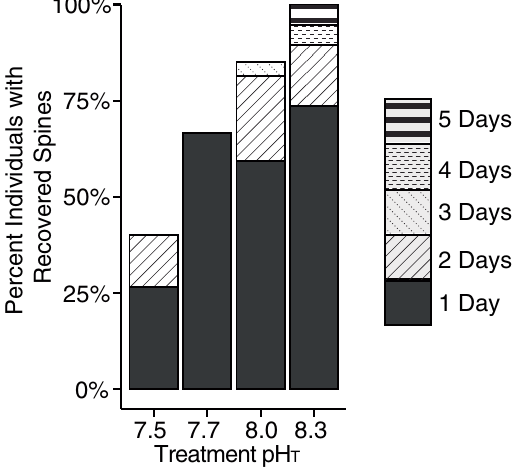
Figure 3. Percentage of individual foraminifera that regrew spines at each of four pH conditions. The number of days between experiment start and regrowth are shown in patterned bars. After 5 days, significant differences were found between foraminifera exposed to pH 7.5 vs. pH 8.0 and 8.3 (ANOVA; F 3,83 = 13.64; p-value < 0.01).